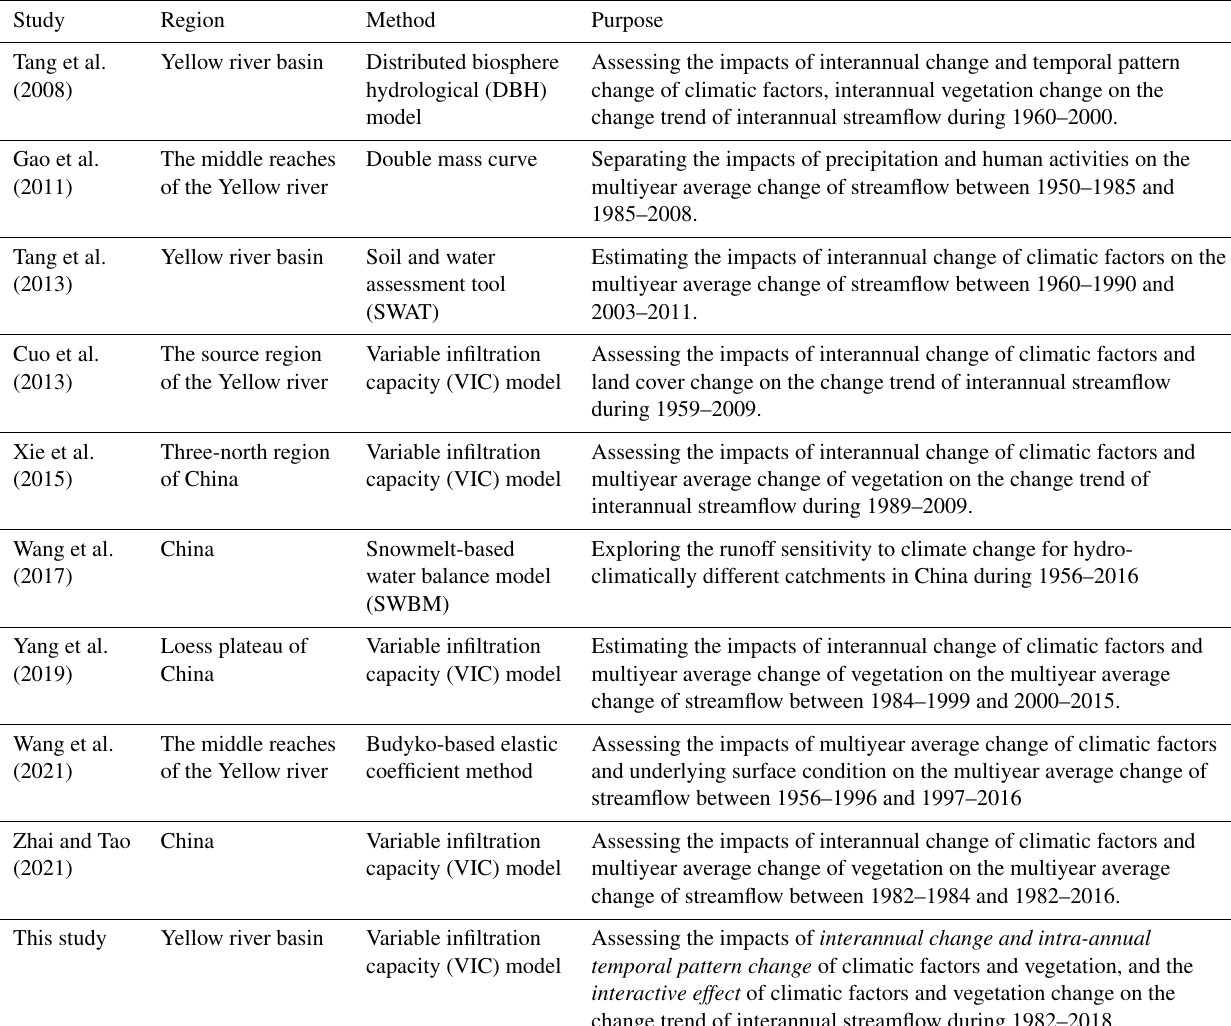
Table 1. Summarizing typical studies carried out in the YRB and China for attributing interannual streamflow change.